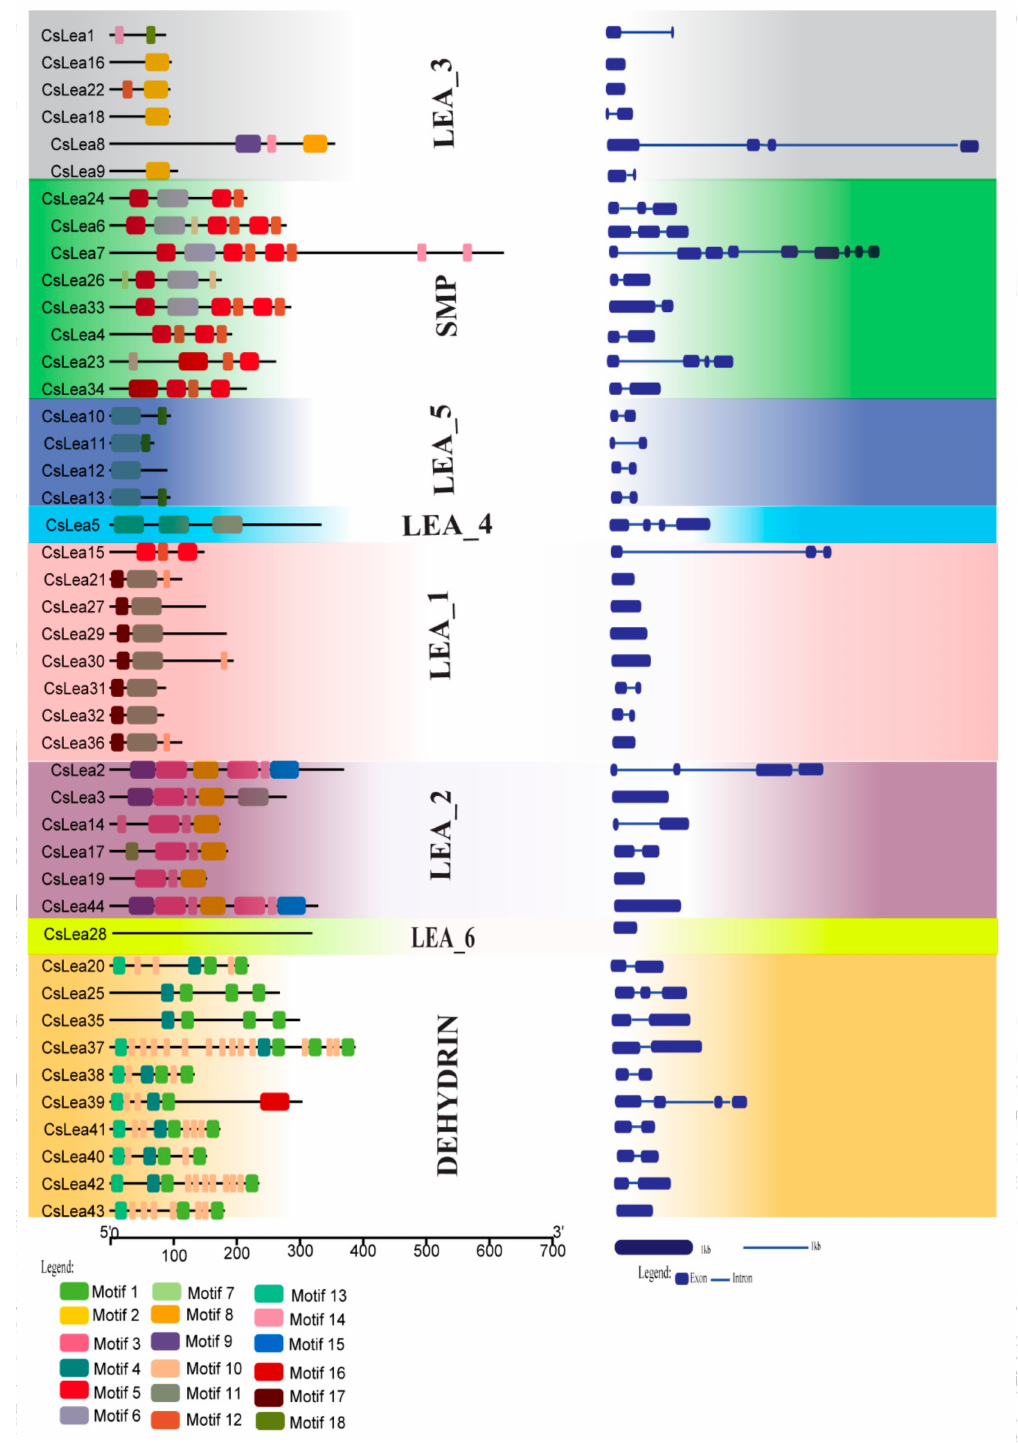
Figure 2. Motif structure and exon–intron organizations of the 44 CsLEA genes. The 18 motifs discovered in this study are shown on these CsLEA genes ( left ). The blue boxes represent exons and the blue lines represent introns ( right